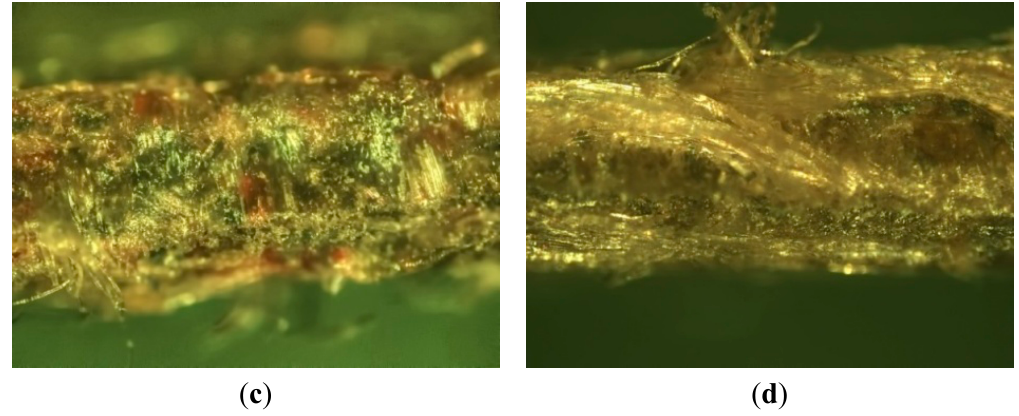
Figure 3. Optical micrographs of CNFC composite ( a , c ) and the NFC composite ( b , d ). The images ( a ) and ( b ) are of the composite surface whilst the images ( c ) and ( d ) are of the centre cross-section